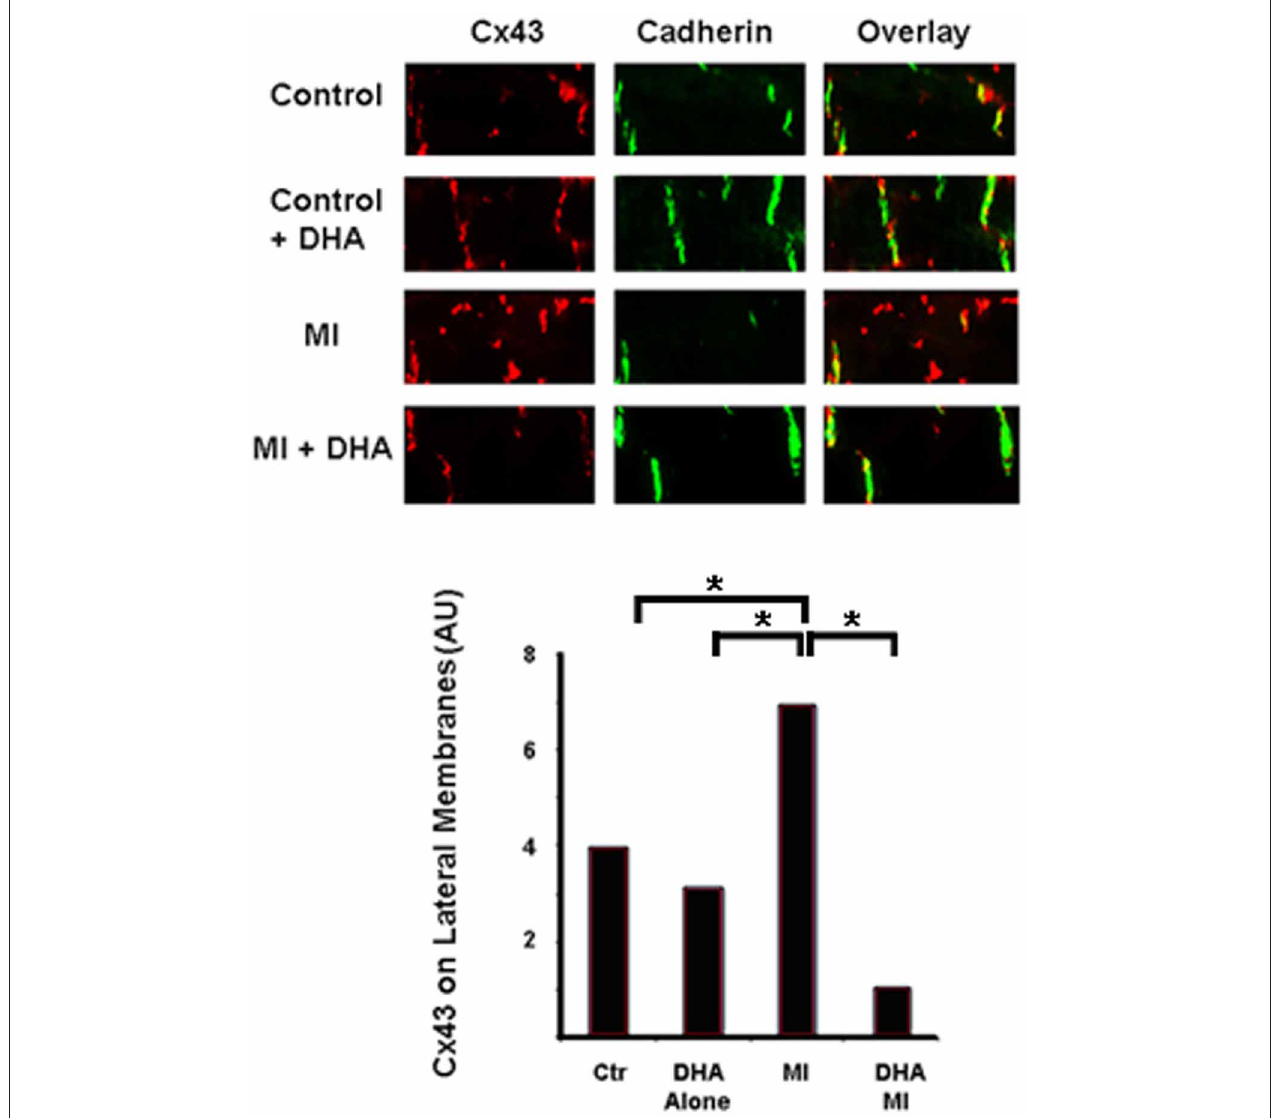
FIGURE 4 | Immunostaining of Cx43 distribution in control and DHA-treated mice following myocardial infarction. Cx43 (red) is found at the intercalated disks (Cadherin was used as a marker of the disk, green) in